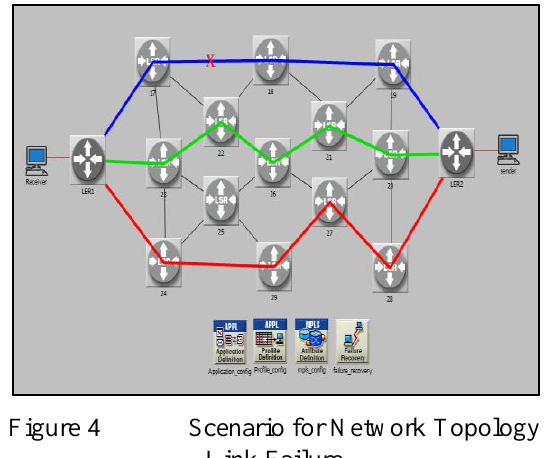
Scenario for Network Topology